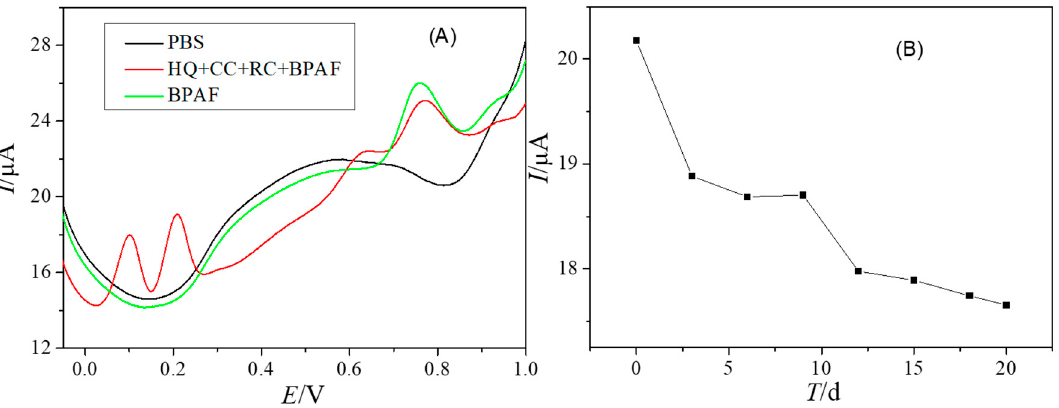
Figure 6. DPVs of PtNPs@GDY/GCE in 0.1 M PB (pH 6.0) with 0.5 μ M BPAF, 2 μ M HQ, 1 μ M CC